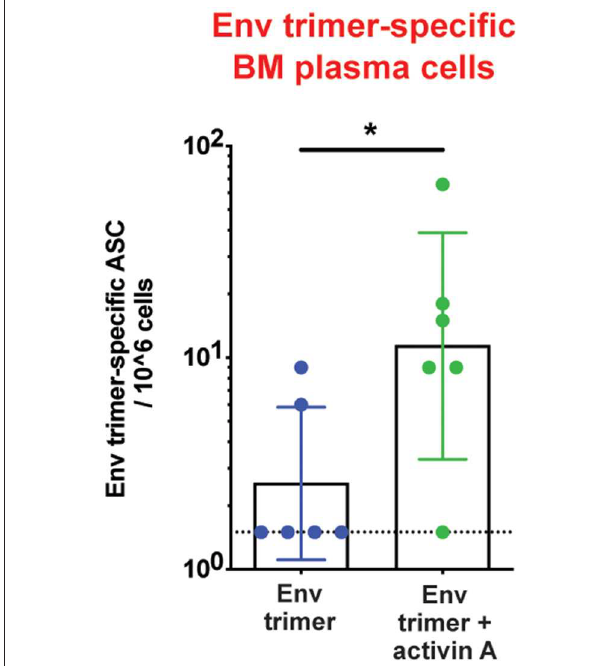
FIGURE 2 | Activin A’s regulation of bone marrow Ab-secreting cells. Bone marrow Env trimer-specific IgG secreting cells were measured by ELISPOT at the necropsy time point. Bars show geometric mean with geometric SD. Dotted line represents limit of detection. * p <